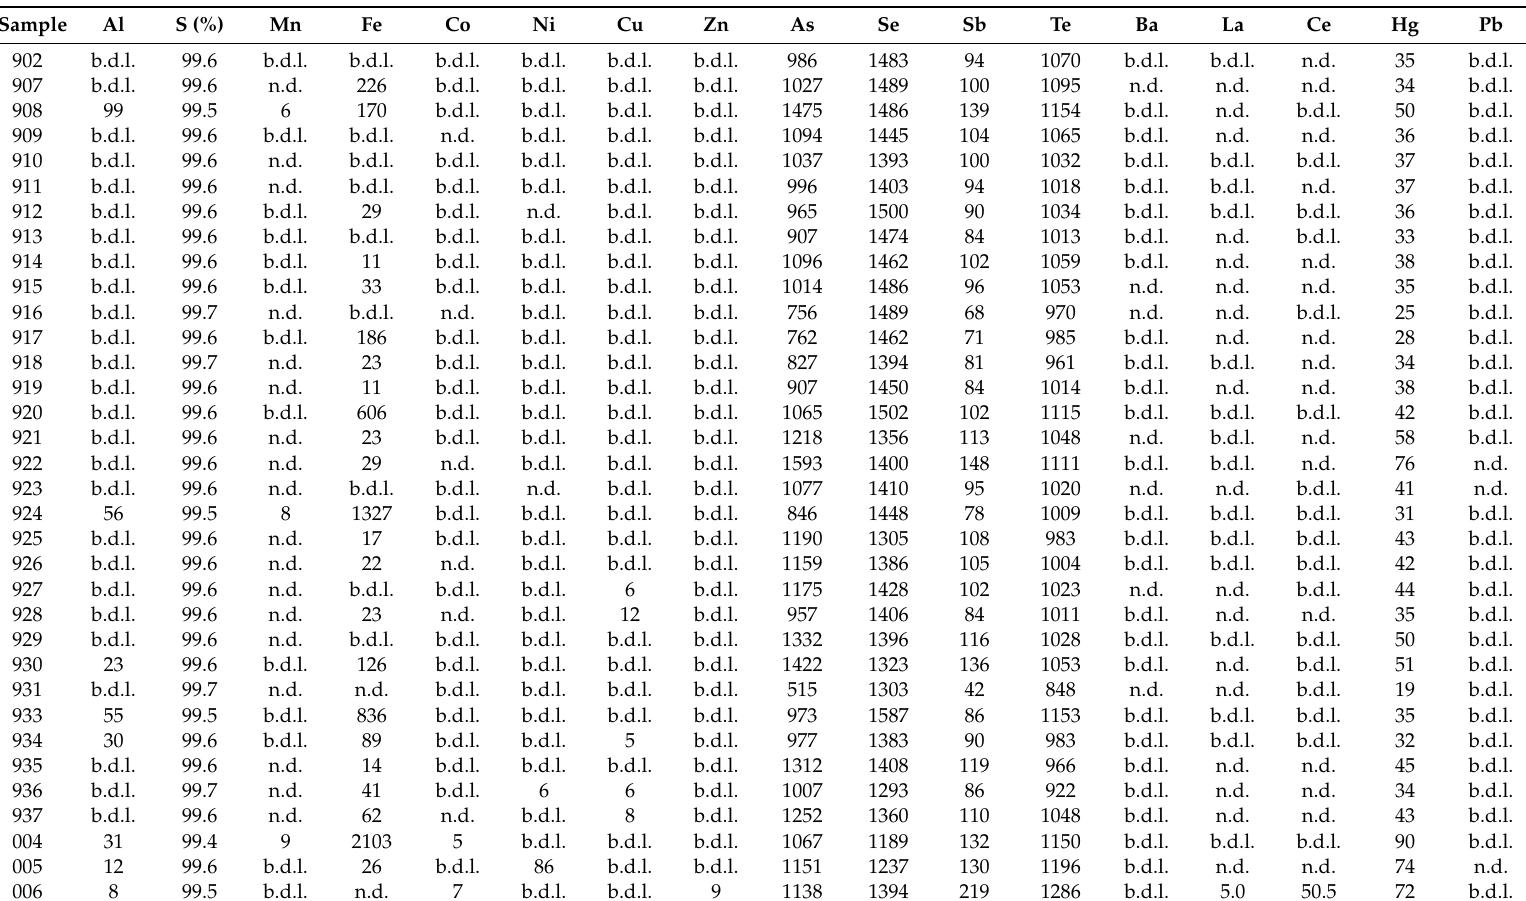
Table 1. Laser ablation inductively coupled plasma mass spectrometry (LA-ICPMS) results for the sulfur matrix of the native sulfur aggregates from Kueishantao area (all in ppm except for